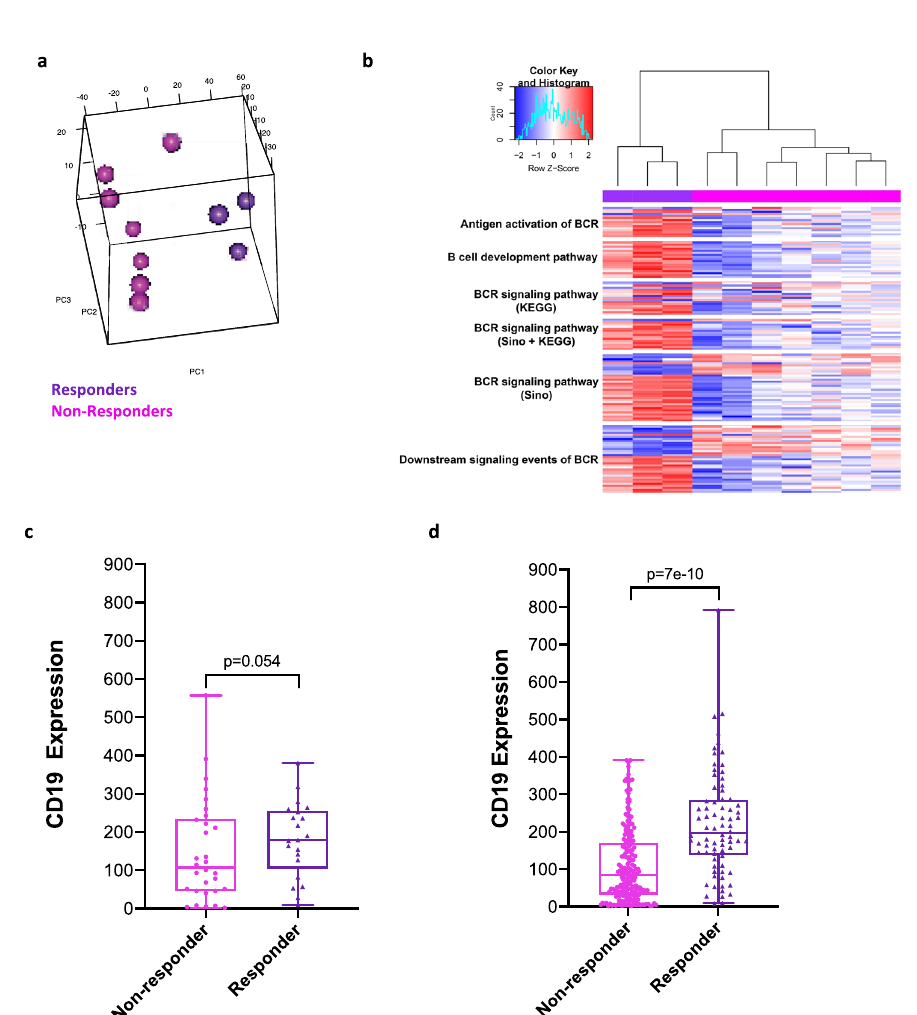
Fig. 9 FEC + oHSV-1 induces dichotomous response, with responders having upregulation of B-cell receptor signaling pathways and downregulation of genes associated with immunosuppressive phenotypes. a 3-D cluster plot showing the RNA expression correlations between mice treated with FEC + oHSV-1 (non-responders = pink; responders = purple). b Heat map showing the normalized expression values of genes associated with B-cell receptor signaling pathways, across all FEC + oHSV-1 samples. c CD19 mRNA expression was compared between responders ( n = 23) versus non-responders ( n = 30) to FEC treatment in a cohort of HER2(-) ER(-) breast cancer patients [AUC = 0.657 Mann – Whitney p value = 0.054]. d CD19 mRNA expression was compared between responders ( n = 84) versus non-responders ( n = 219) to FEC treatment in a cohort of all breast cancer patients [AUC = 0.729, Mann – Whitney p value < 0.001]. Response de fi ned as complete pathological response versus residual disease after completing therapy. *BCR B Cell